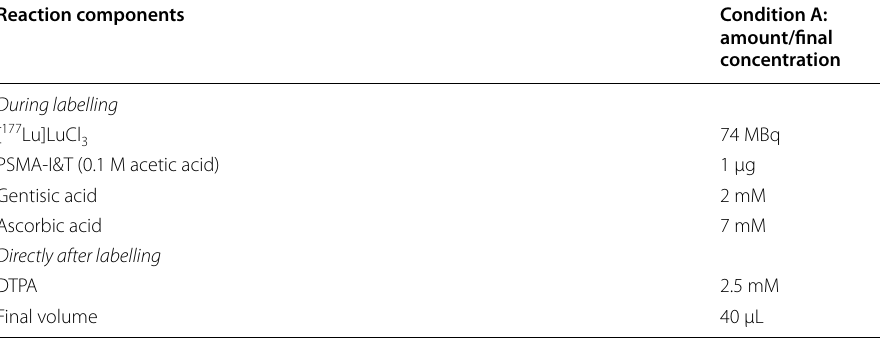
amount/final concentration